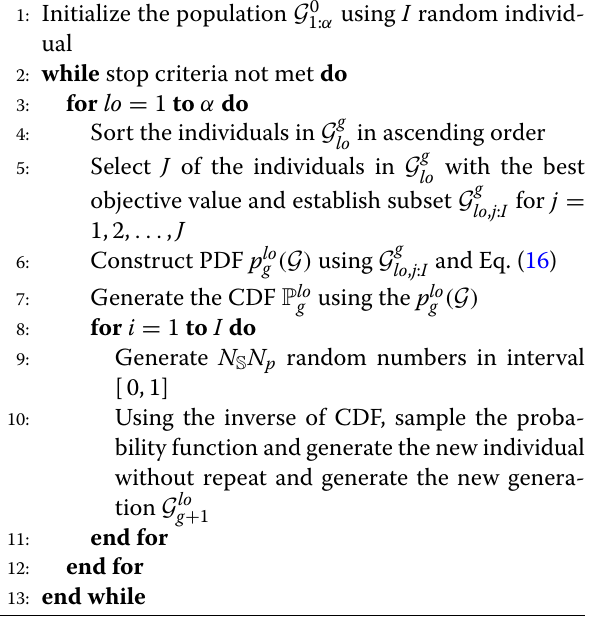
Algorithm 4 Parallel Cross-Entropy-based pilot alloca-